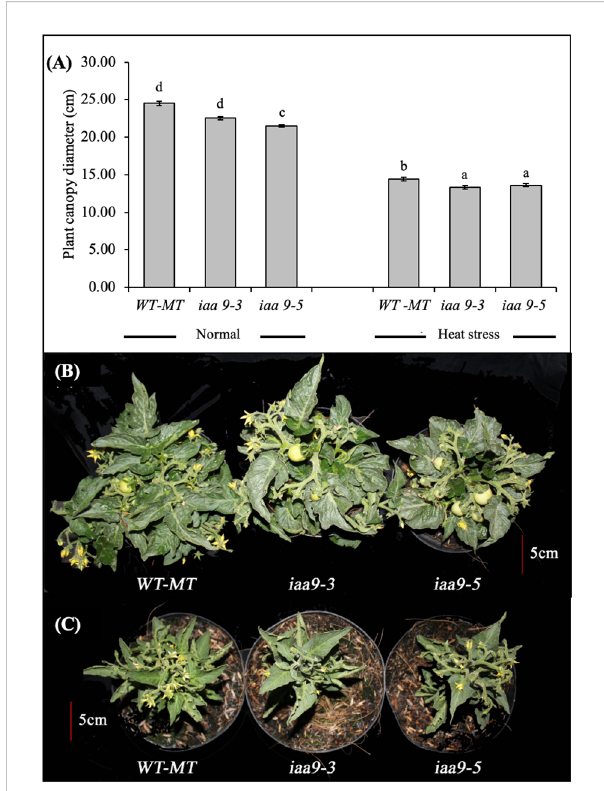
FIGURE 1 (A) The average value of the plant canopy diameter of WT-MT, iaa9- 3 , and iaa9-5 under two temperature conditions. The plant canopy of WT-MT, iaa9-3 and iaa9-5 under (B) normal temperature and (C) heat stress condition. The average value ± standard error (SE) (n = 4) followed by the same lowercase letters is not signi fi cantly different based on Duncan ’ s Multiple Range Test at